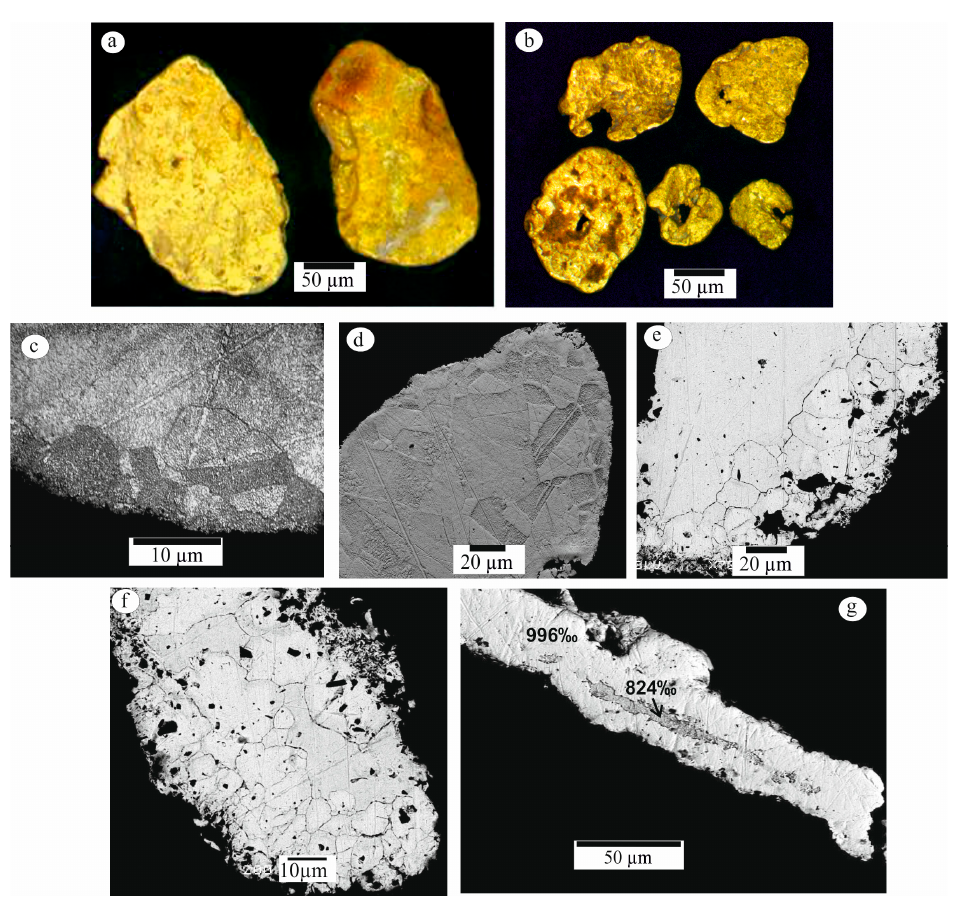
Figure 4. Morphology and internal structure of rounded high-fineness gold from the Billyakh river placer, supplied from intermediate sources: ( a ) scaly gold; ( b ) lamellar gold with casts of pressing of minerals on the surface and with through holes; ( c , d ) recrystallization structures; ( e , f ) granulation structures, etched with a reagent based on aqua regia; ( g ) relics of medium-fineness gold in the central part of the scale almost completely replaced by high-fineness gold; ( c – g ) shot in BSE mode. Along with this gold, very fine ( − 0.2 mm) slightly rounded with lamellar and angular, lumpy forms were found in all studied samples, up to 15% (Figure 5a,b). Their surface is rough, spongy, and porous. The fineness varies in very wide intervals, from low (514‰) up to very high (999‰) (Table 1). The analysis of the fineness of gold and its morpho- logical features has shown that exclusively gold particles of ore habit have relatively low (799‰–700‰) and low (699‰–500‰) fineness. The main feature of this gold is its hetero- geneous heterophase internal structure, with a block nature. A low-fineness (500‰–600‰) phase was identified in the central part of the gold particles (Figure 5c), and a relatively low-fineness one along the periphery (750‰). An intermittent very thin (the first microns) high-fineness phase, characterized by a lighter shade, is observed along the marginal parts of relatively low-fineness gold (Figure 5d, is shown by yellow arrows). The sharpness and discontinuity of the high-fineness margin indicate a short-time residence of this gold in exogenous conditions. In general, the set of typomorphic features of this gold indicates the presence of nearby primary